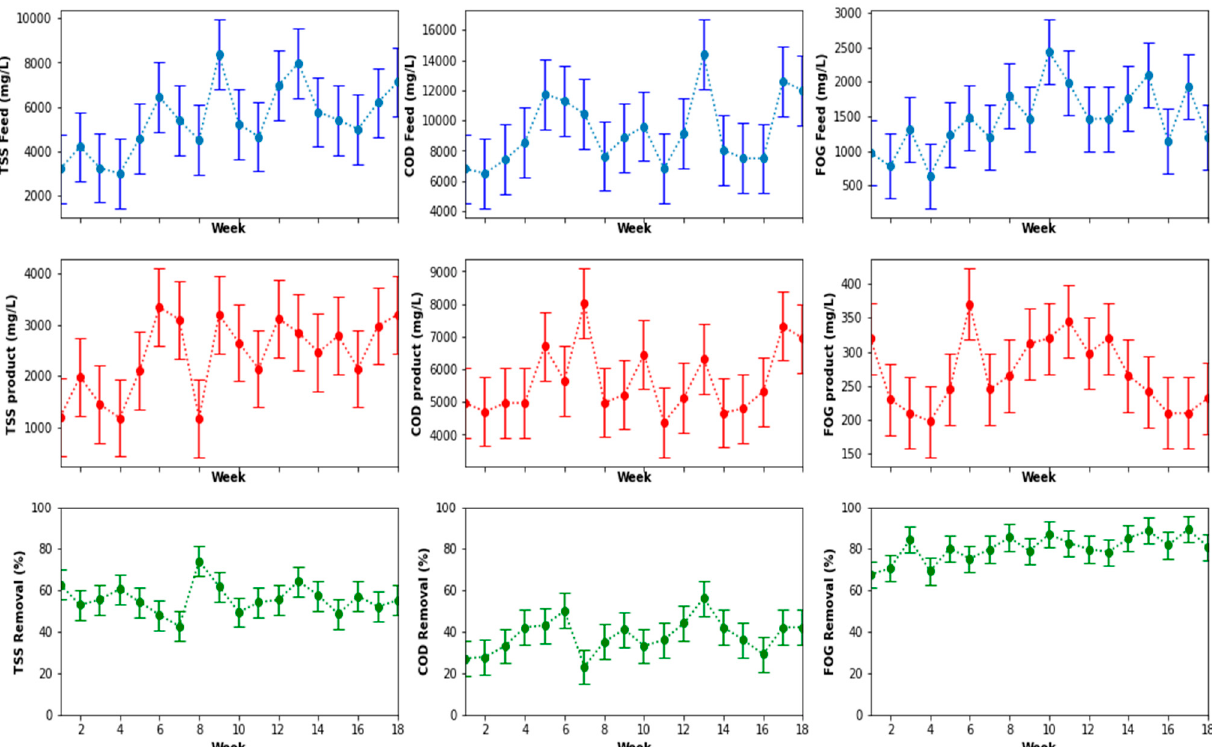
Figure 6. Performance of the pre-treatment system after outlier replacement.